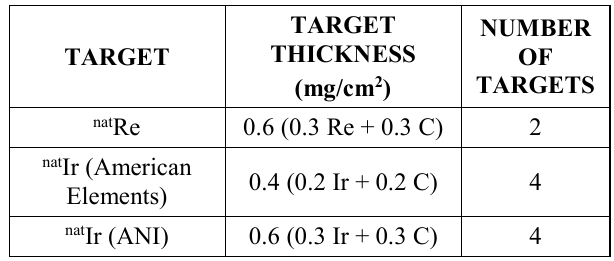
Table 1. Prepared Targets and